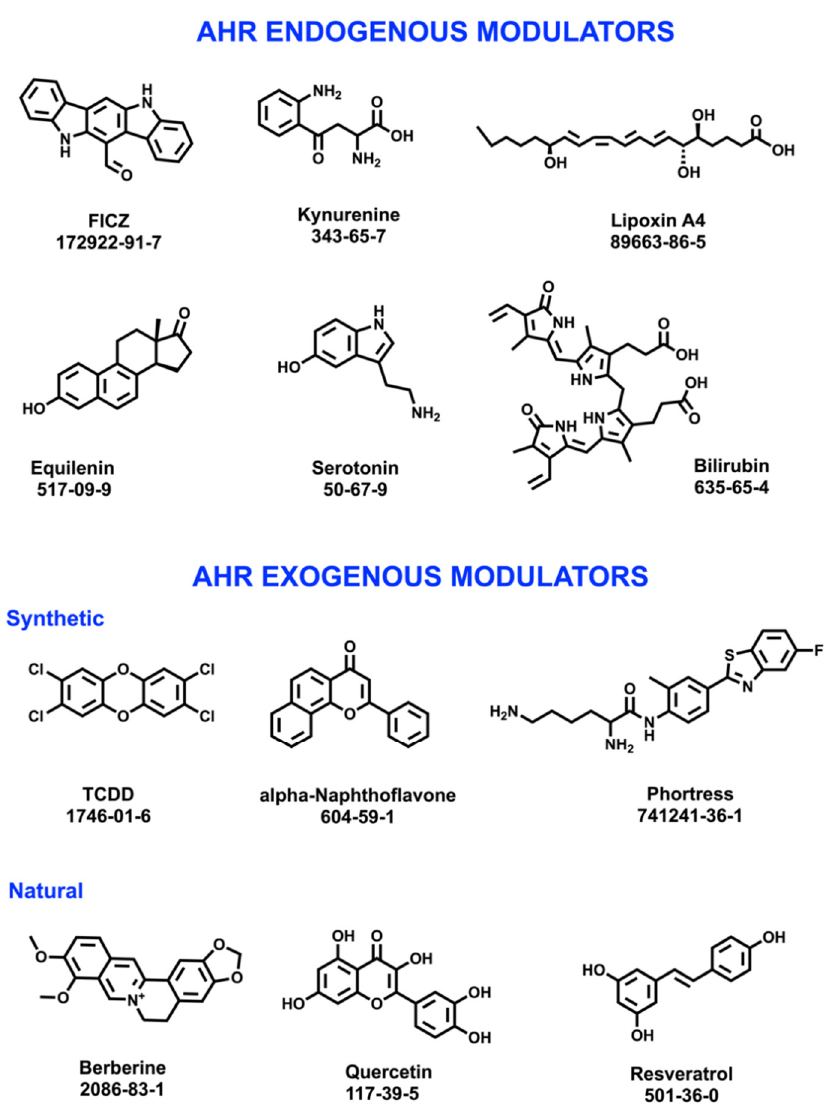
Figure 3. Examples of AhR endogenous and exogenous modulators (structures, common names, and CAS numbers are shown).